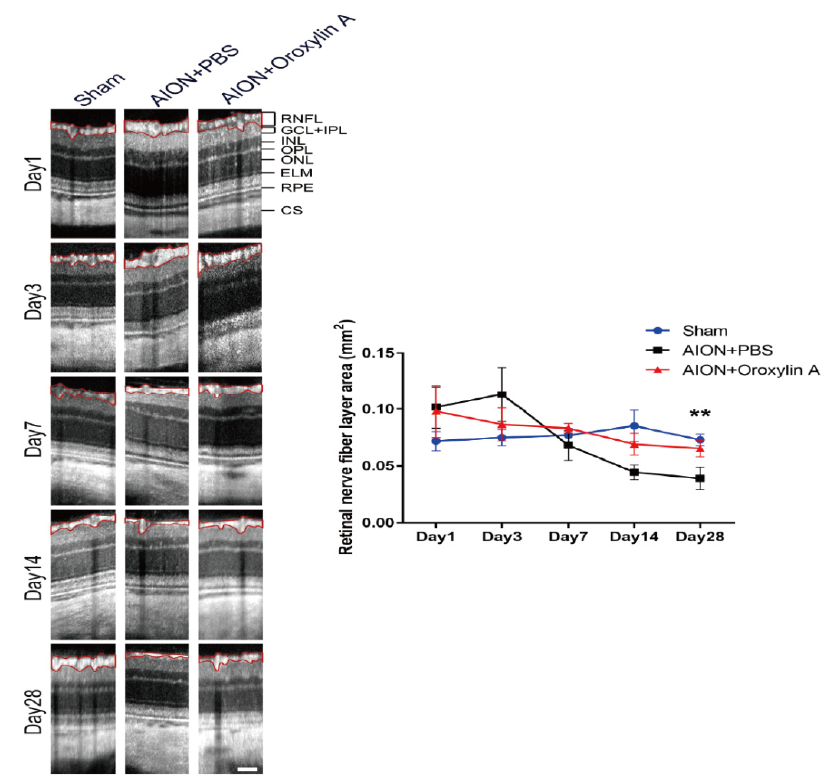
Figure 5. OCT profiles of the retinal nerve fiber layer (RNFL). Representative RNFL thickness measurements for the sham, PBS-treated, and OA-treated groups on Days 1, 3, 7, 14, and 28. Com- pared with the PBS-treated group, the OA-treated group exhibited significant preservation of the RNFL on Day 28 after infarction. (0.039 ± 0.001 m m 2 versus 0.065 ± 0.0074 m m 2 , respectively). Re- sults represent the means ± SDs. Scale bar, 130 μ m; ** p < 0.01; n = 6. RNFL: retinal nerve fiber layer; GCL + IPL: ganglion cell layer + inner plexiform layer; INL: inner nuclear layer; OPL: outer plexiform layer; ONL: outer nuclear layer; ELM: external limiting membrane; RPE: retinal pigment epithelium; CS: choroidal stroma.